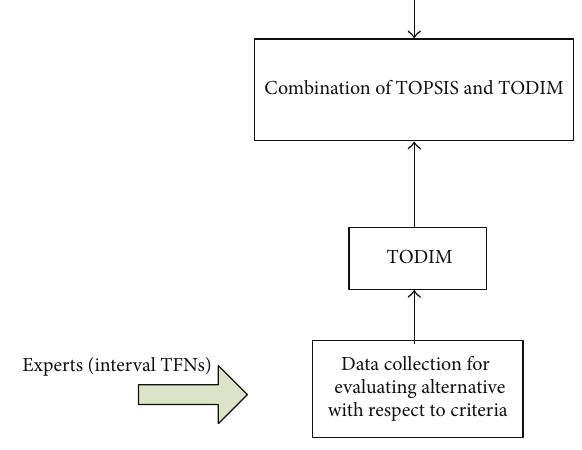
Figure 4: Flowchart of the method.